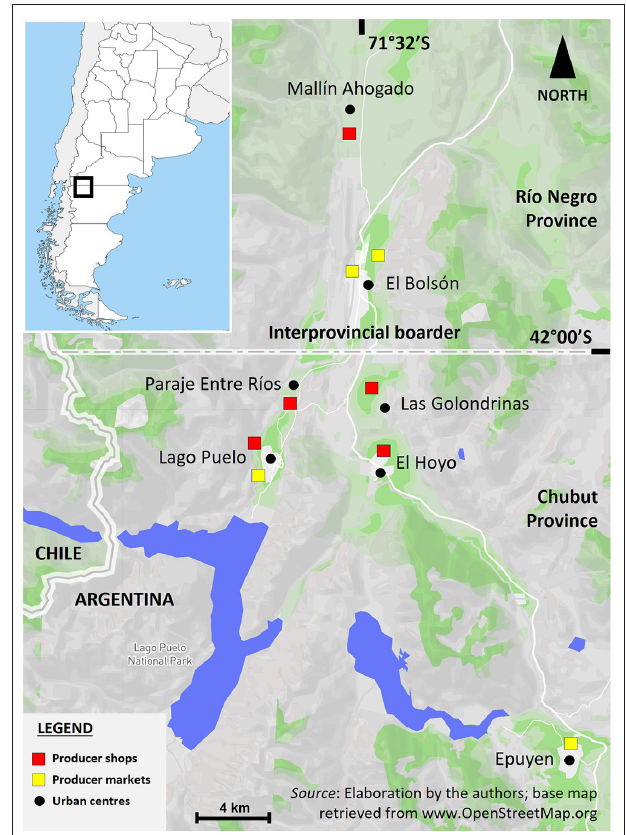
FIGURE 1 | Map of the study region and assessed